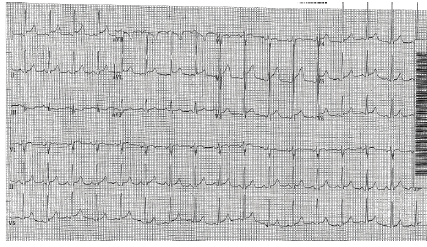
Figure 1: Initial EKG.